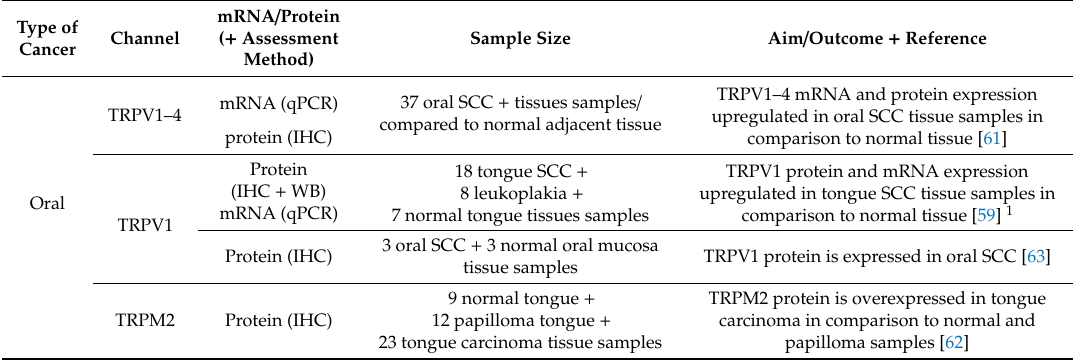
Table 1. Expression of transient receptor potential (TRP) channels in human oral